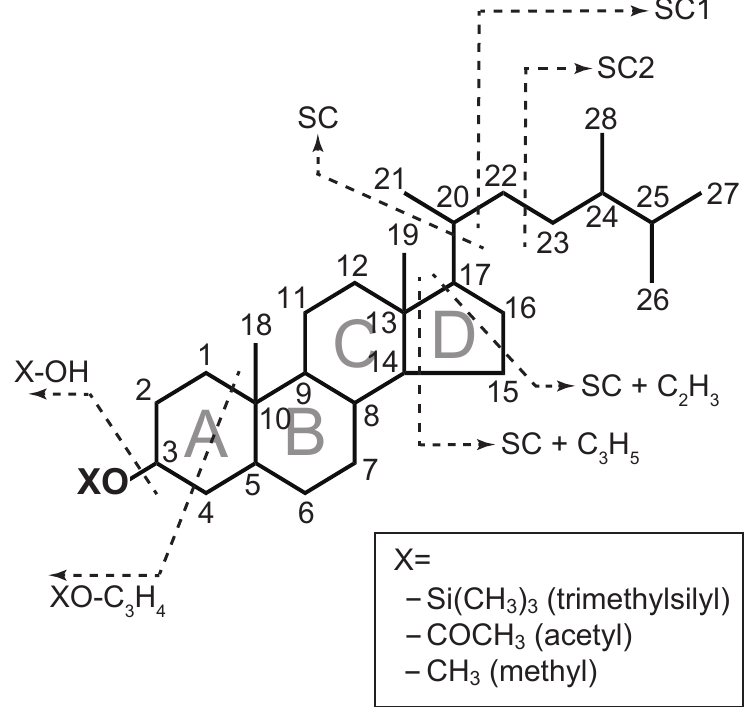
Figure 1. Diagnostic fragmentation of the sterols. Each number represents the position of the carbons. X varied with derivatization, for example, –Si(CH 3 ) 3 in trimethylsilyl, –COCH 3 in acetyl, and –CH 3 in methyl ethers. The X of the original sterols is H (i.e., –OH). SC refers to the side